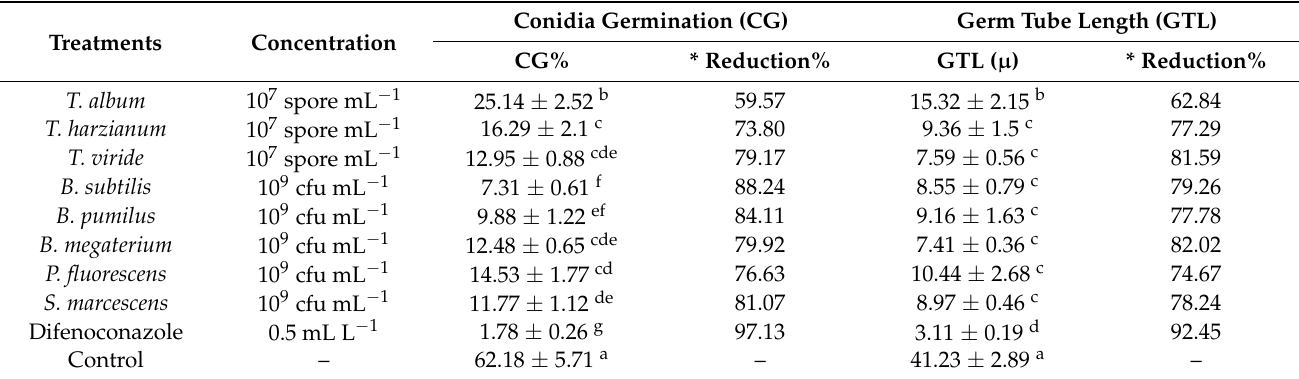
CG = conidia germination, and GTL = germ tube length. * Values are calculated according to the control value. Values followed by the same letter within the same column are not significantly different at a p ≤ 0.05 statistical level, according to Duncan’s multiple range